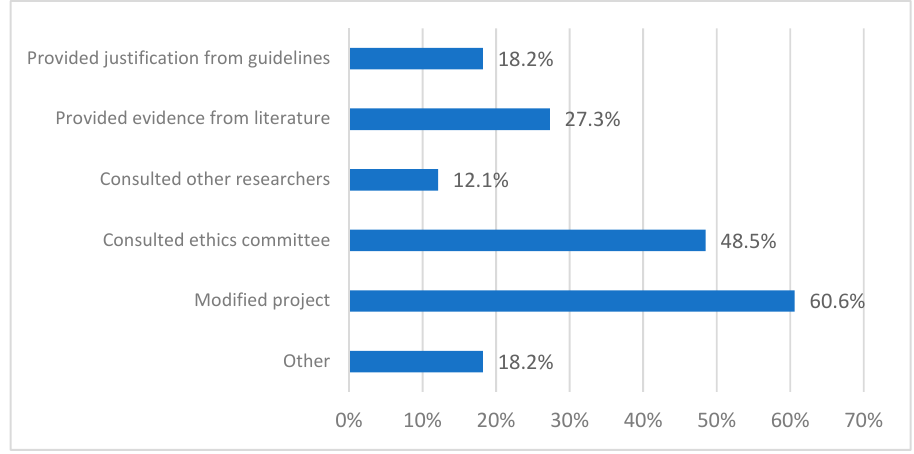
Figure 2. Response to concerns raised 1 . 1 Total is >100% because multiple answers were allowed.